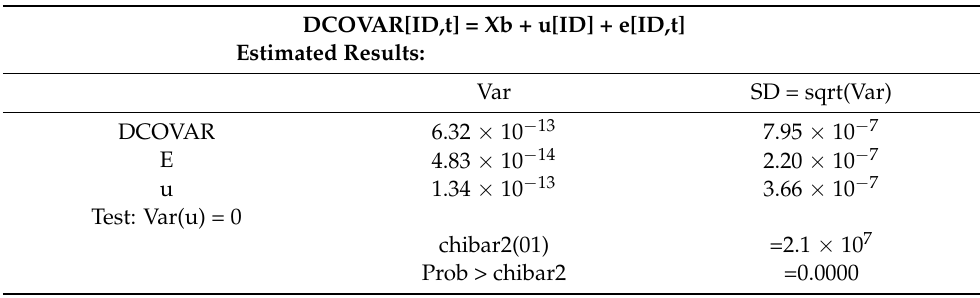
Table 11. Breusch Pagan test. Breusch and Pagan Lagrangian multiplier test for random effects.